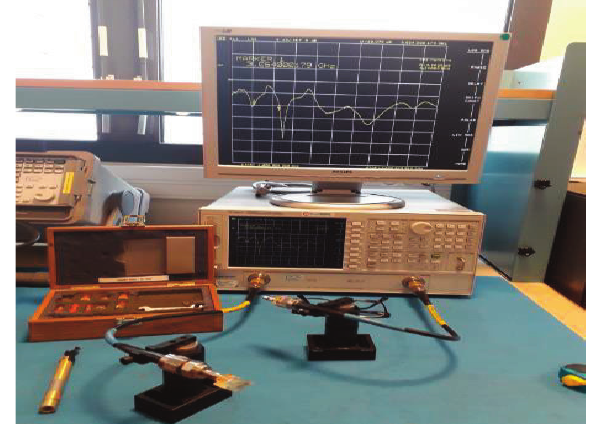
Fig. 10. The measurement setup using VNA.